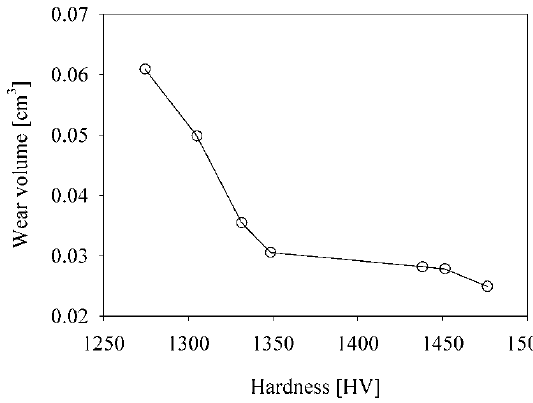
Figure 9. Wear volume vs. the hardness of the WC-10Co cemented carbides.